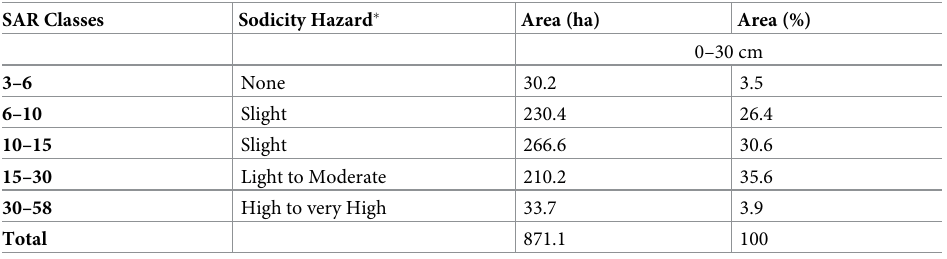
Table 6. Sodicity classes for soil surface and coverage area of salinity zones in the study